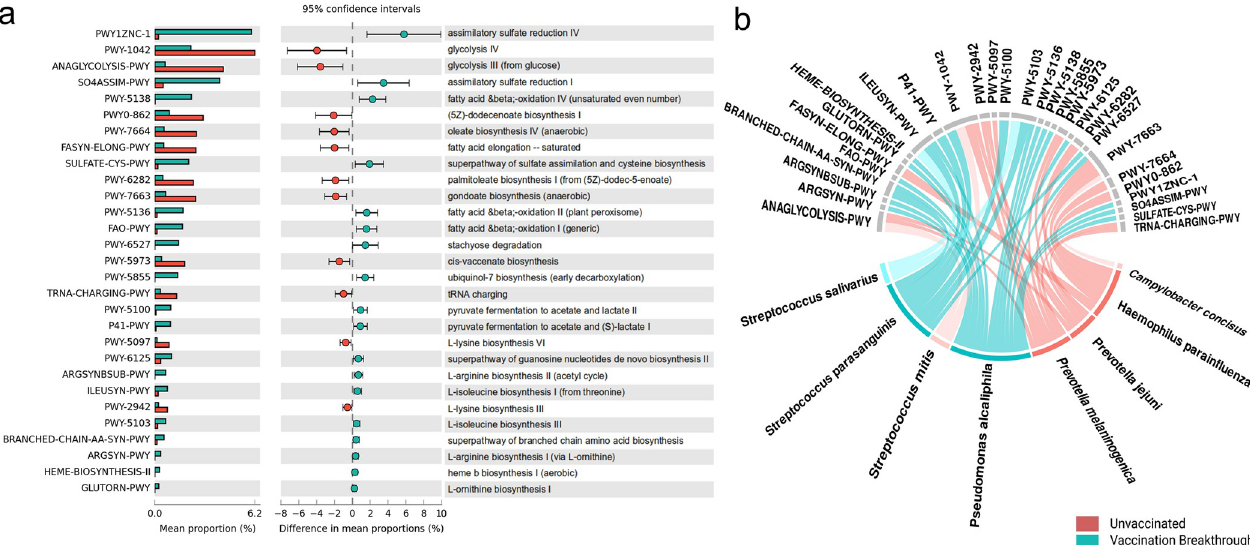
Fig 6. Functional metabolic pathways analysis for the differentially abundant microbial species. (a) Top 29 MetaCyc pathways identified through STAMP analysis which are differentially significantly abundant for the unvaccinated and the vaccination breakthrough patients. (b) Bacterial species contribution from the unvaccinated and vaccination breakthrough cohort leading to enrichment of the top 29 MetaCyc pathways. The color gradient denotes differences in enrichment of pathways based on bacterial species contribution.